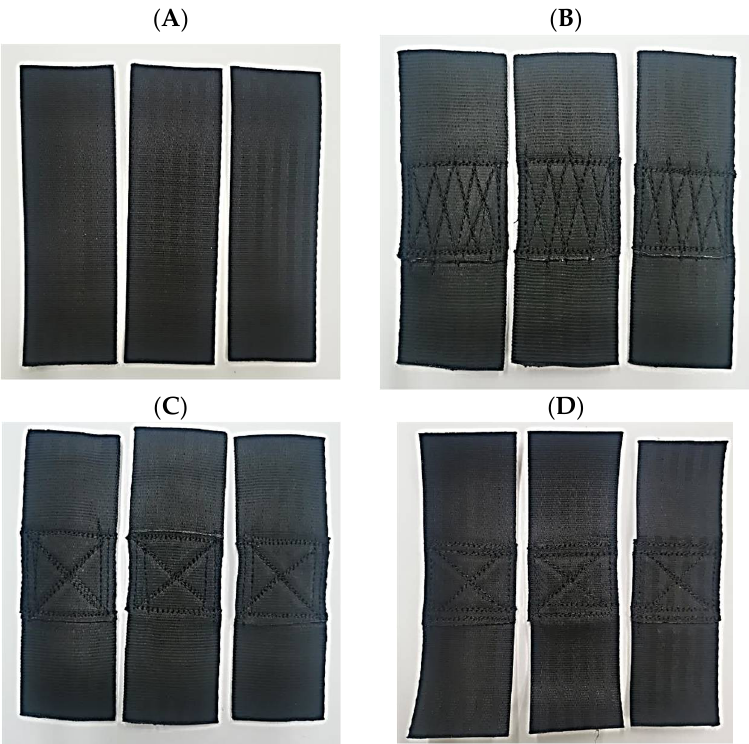
Figure 4. TE324 polyester belts: ( A ) without seams; ( B ) zigzag stitch, straight transverse; ( C ) straight, longitudinal cross stitch; ( D ) cross stitch, straight cross stitch; Source: Own research (2021).